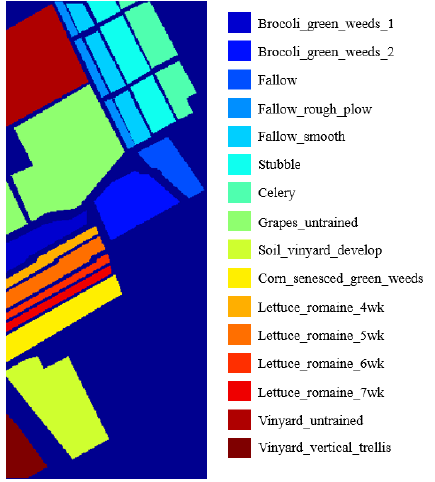
Figure 8. The groundtruth of Salinas Dataset. Table 3. Labeled samples in Salinas Dataset.